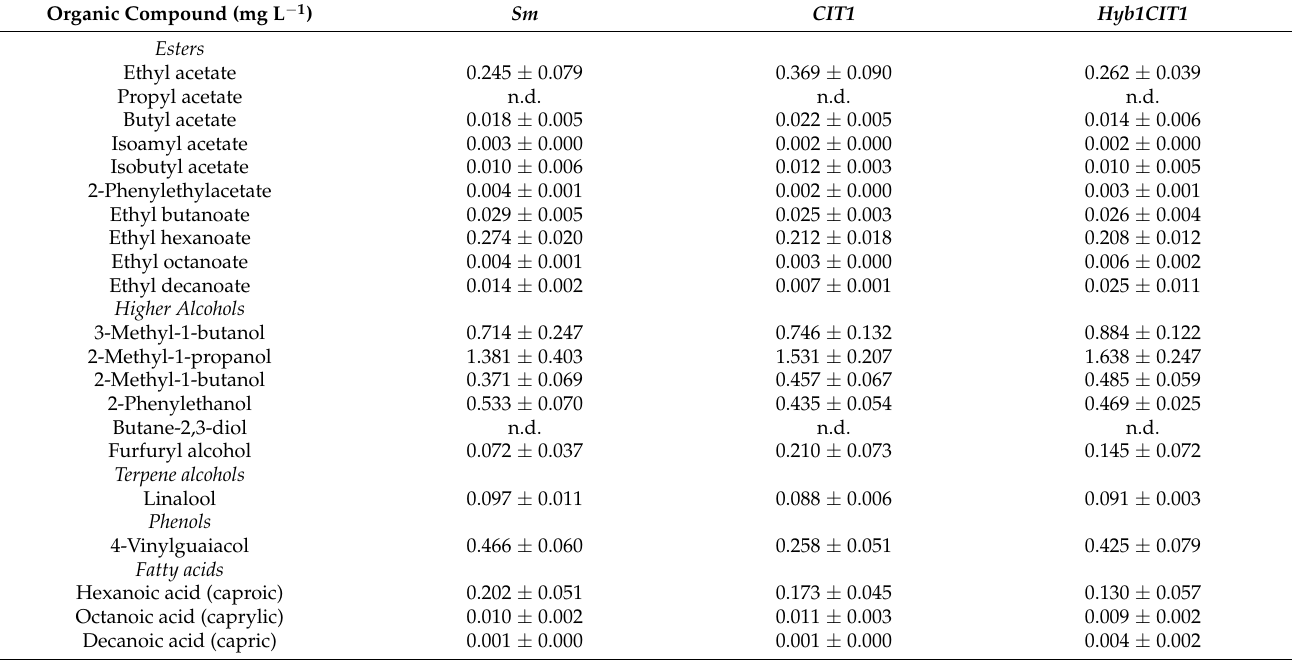
Table 7. Content of volatile organic compounds (VOCs) in beers ( Sm , CIT1 and Hyb1CIT1 ) produced from 7 ◦ P